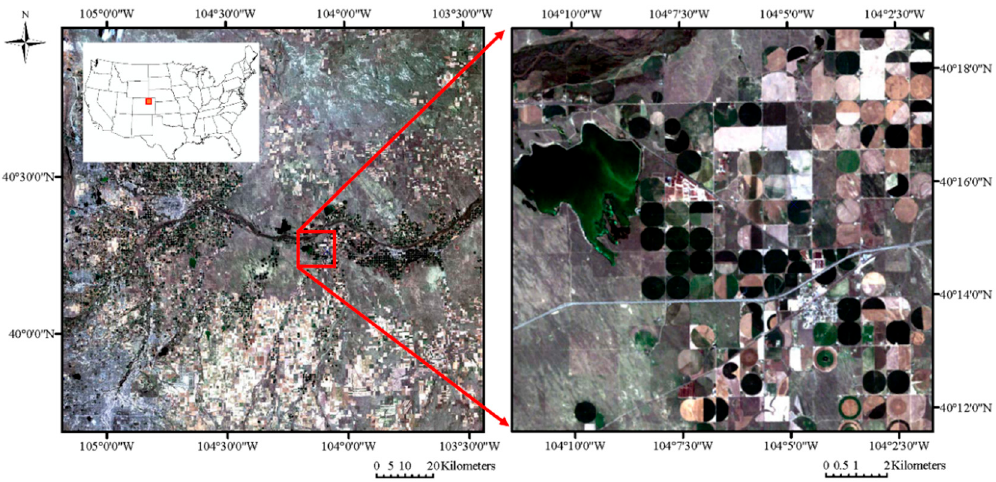
Figure 1. Landsat 5-TM image in the north-east of Colorado State on 19 July 2011, with resolution of 30 m.